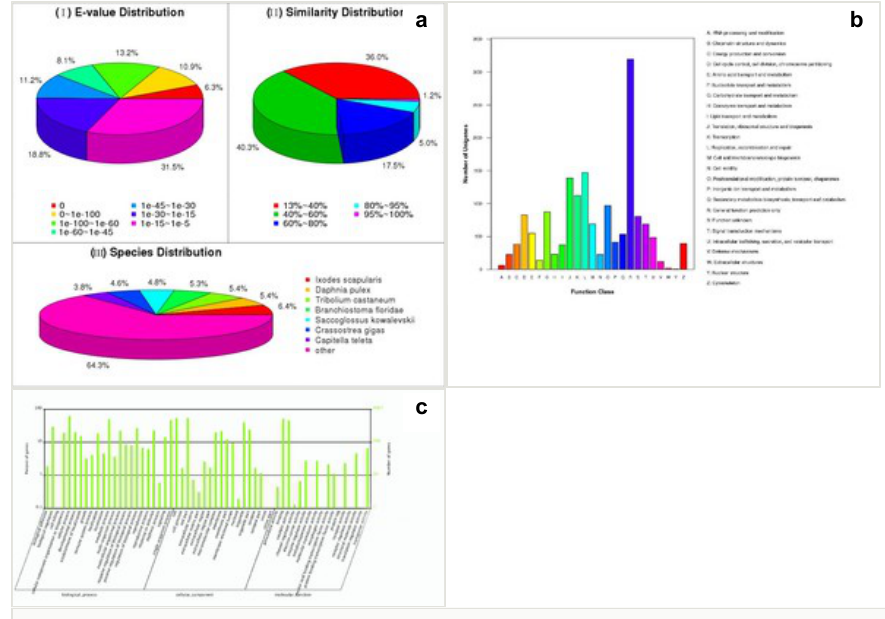
Figure 20. Gene annotation. Original data available from GigaScience GigaDB (Stoev et al. 2013). a : E-value, identity and species distribution statistics of the sequences that can find homologs